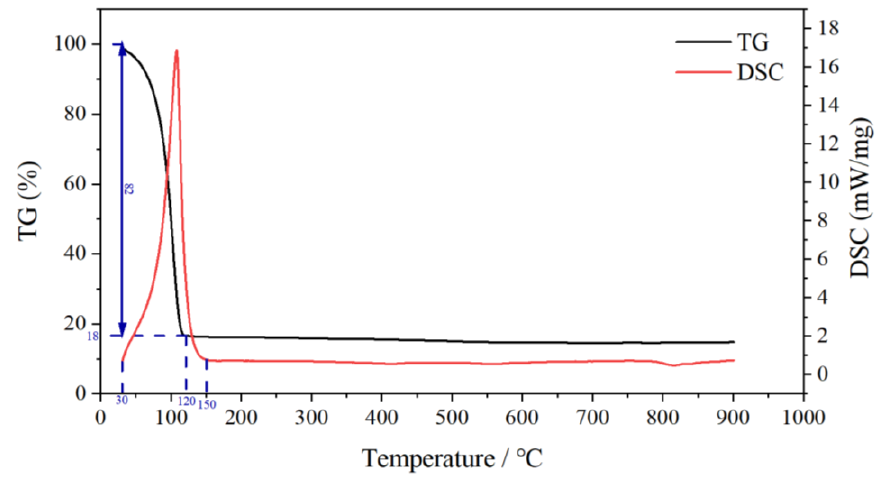
Figure 12. TG-DSC curves of the LMP-Bt